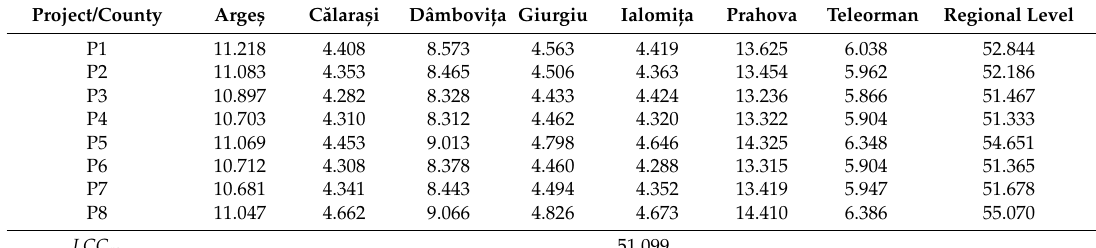
Table A1. LCC at the regional level for the minimum scenario (billions euro).